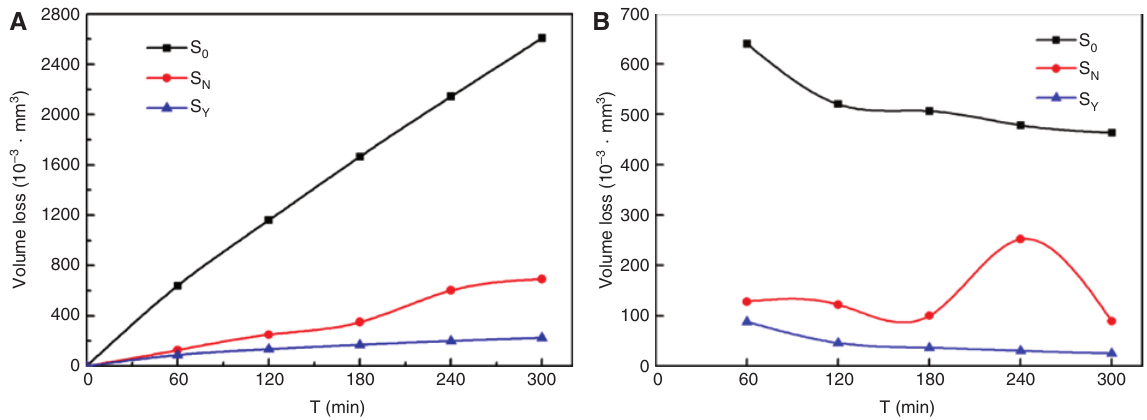
Figure 14: Wear results of samples: (A) total amount of volume loss; (B) volume loss in each test process.